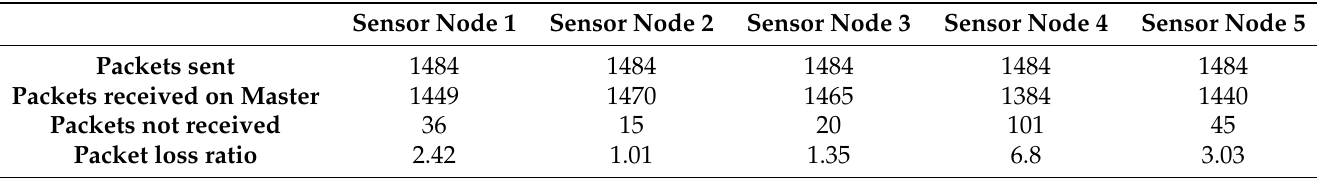
Table 10. LoRa Radio Communication Dynamic